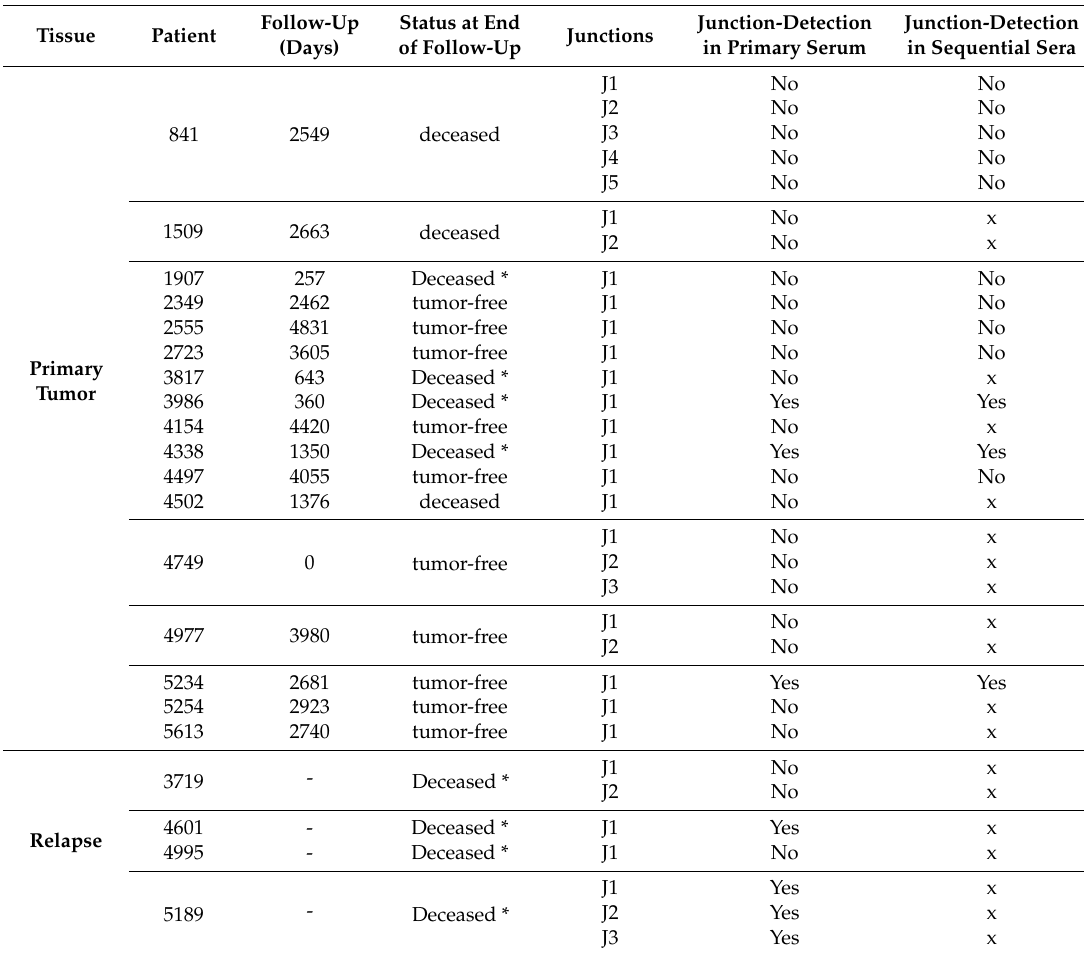
Table 2. Junction detection in primary serum samples and follow-up of